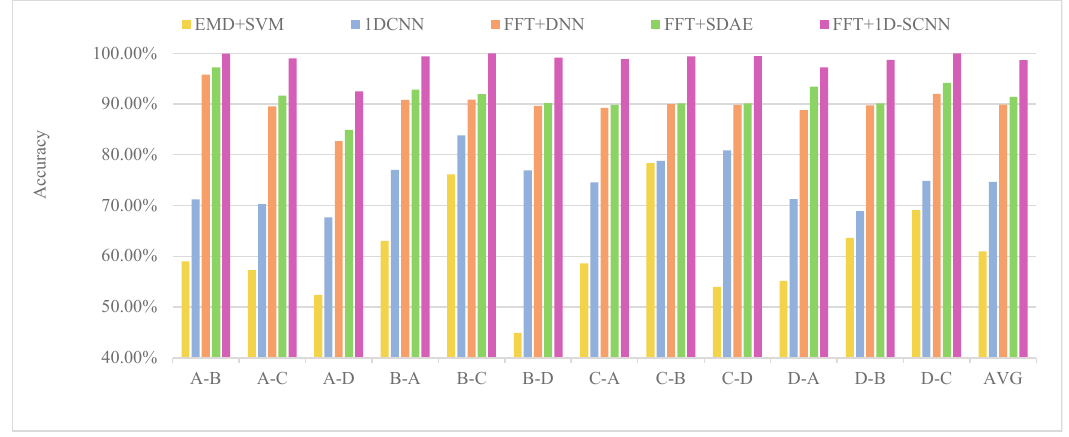
Figure 11. Fault diagnosis accuracy of different methods under cross-load level